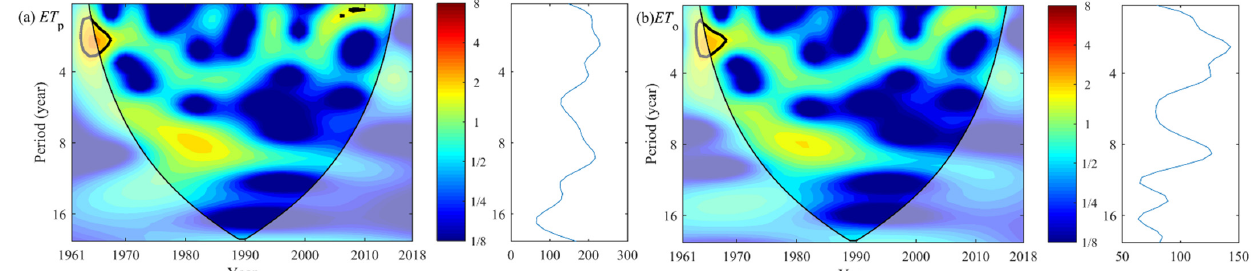
Figure 11. The wavelet spectrum and wavelet variance for the annual ET p ( a ) and ET o ( b ) of main- land China . The thin solid lines denote the cones of influence, and the thick solid lines show the 95% confidence levels. The color bar represents the vibration intensity of the periods at different time- scales.